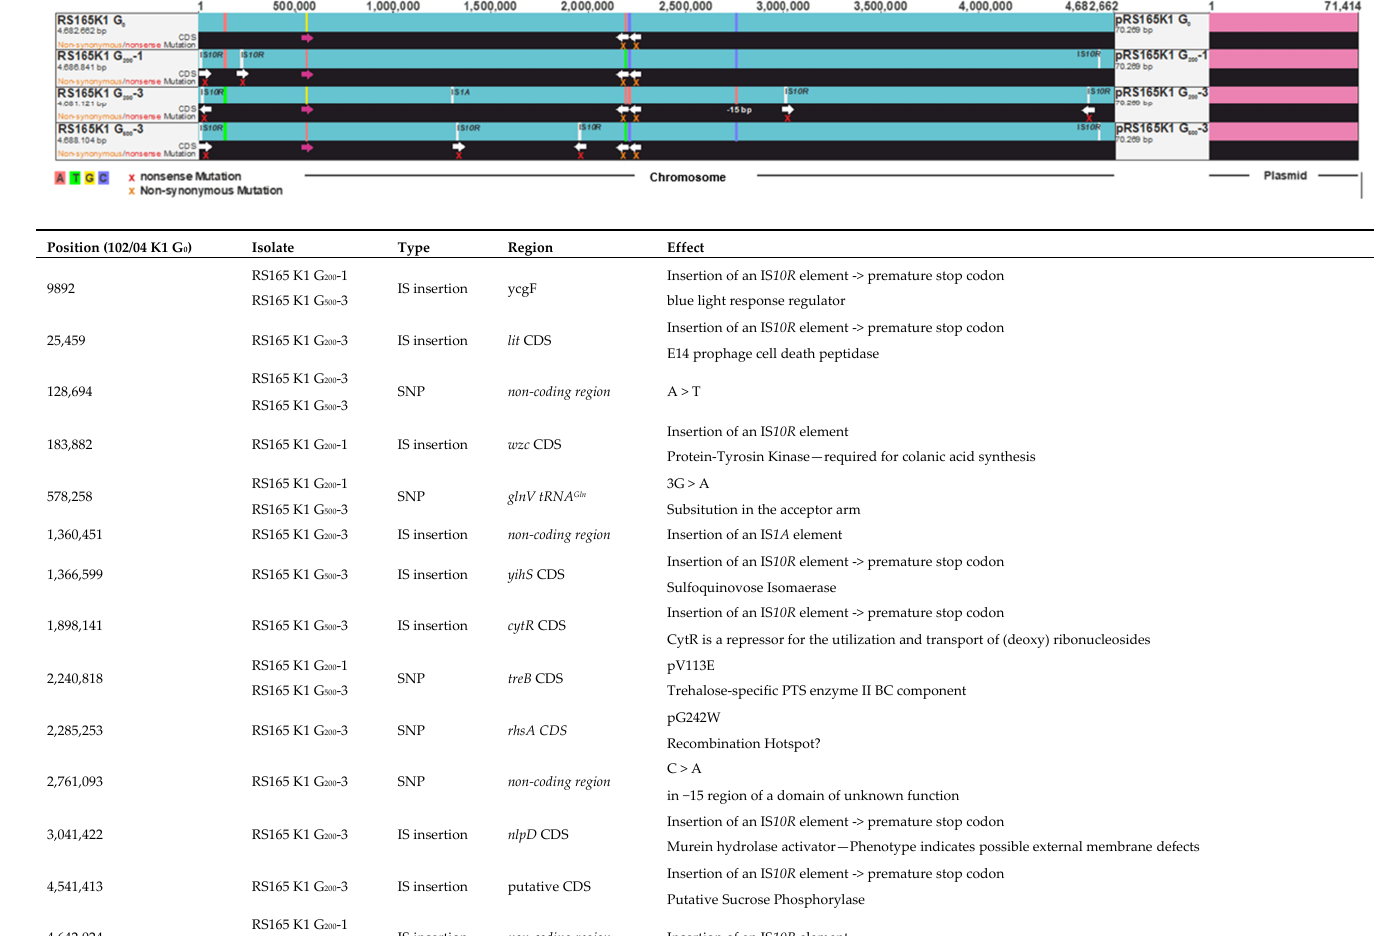
Figure 3. Schematic presentation of the genetic changes of transconjugant isolates 102/04 K1 und K2 after long-term growth . Mutations in the chromosomes and amino acid changes are marked at the respective positions. Base pair substitutions are marked by color. Positions of modified IS elements are highlighted by white bars. White arrows point towards changes in coding sequences.